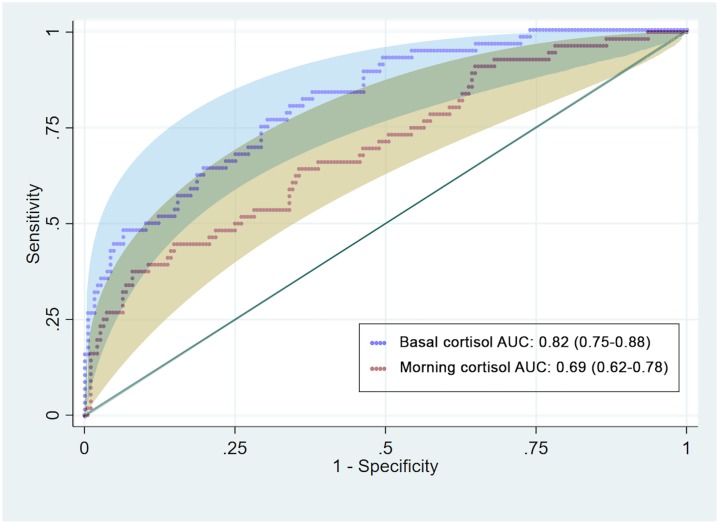
Covariate-adjusted AUCs of 0800 h serum morning cortisol and basal cortisol levels for the diagnosis of AI (adjusted for age, sex, serum albumin level, cholesterol level, creatinine level and ACTH dose).